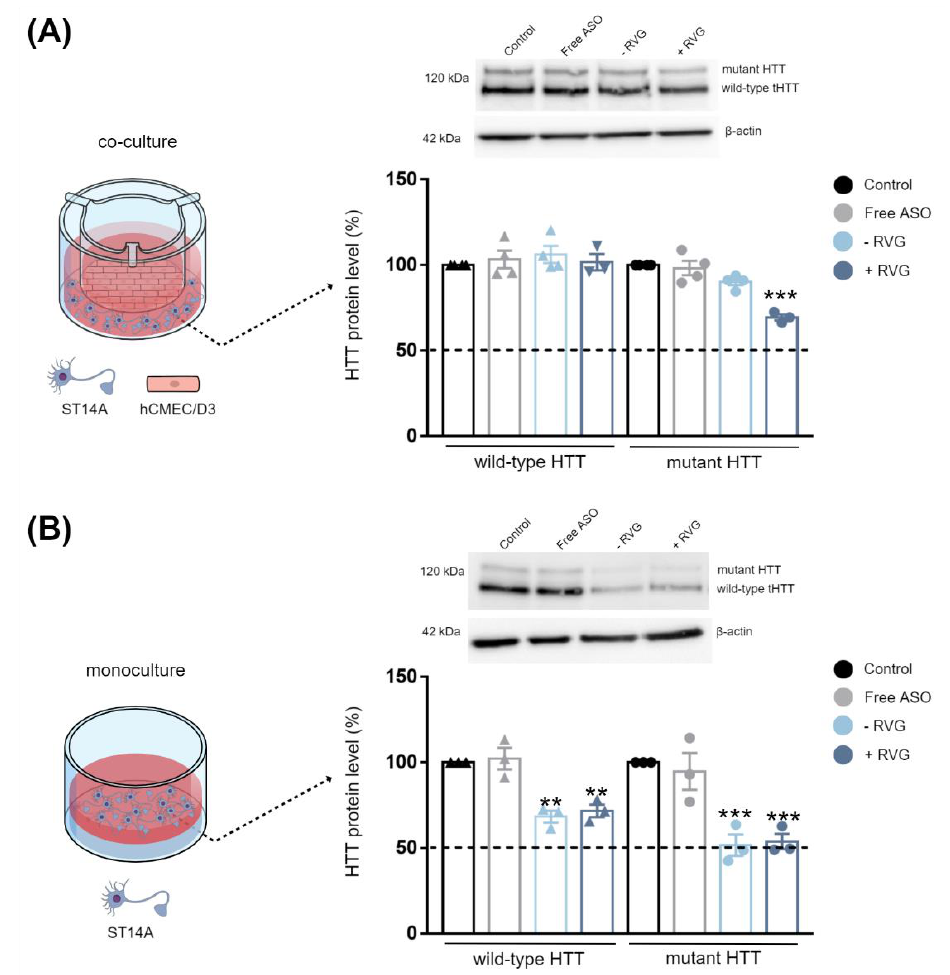
Figure 7. Evaluation of ASO efficacy after transfection with RVG-targeted and untargeted CDs in a co-culture and monoculture model. Schematic illustration of ( A ) the BBB co-culture model containing hCMEC/D3 cells in the apical compartment and ST14A cells in the basal compartment and ( B ) monoculture of ST14A cells. Representative changes in HTT protein expression (MAB2166) in ST14A cells following 72 h treatment with ASO. Mean ± S.E.M of 3–4 technical replicates. ** p < 0.01, and *** p < 0.001 compared to control; Two-way ANOVA with Sidak’s post hoc test. The wtHTT and mHTT levels after direct incubation of ST14A cells alone (monoculture) with RVG-targeted and untargeted nanocomplexes were also evaluated (Figure 7B). The reduction of wtHTT and mHTT expression was higher in the monoculture ST14A cells than in the co-culture model, indicating that the BBB represents a formidable barrier even for small molecules such as CDs:ASO. As shown in Figure 7B, both RVG-targeted and untargeted nanocomplexes were able to downregulate the wtHTT and mHTT protein levels in a similar manner. The treatments reduced mHTT protein by ~50% ( p < 0.001) and wtHTT protein by ~30% ( p < 0.01) compared to